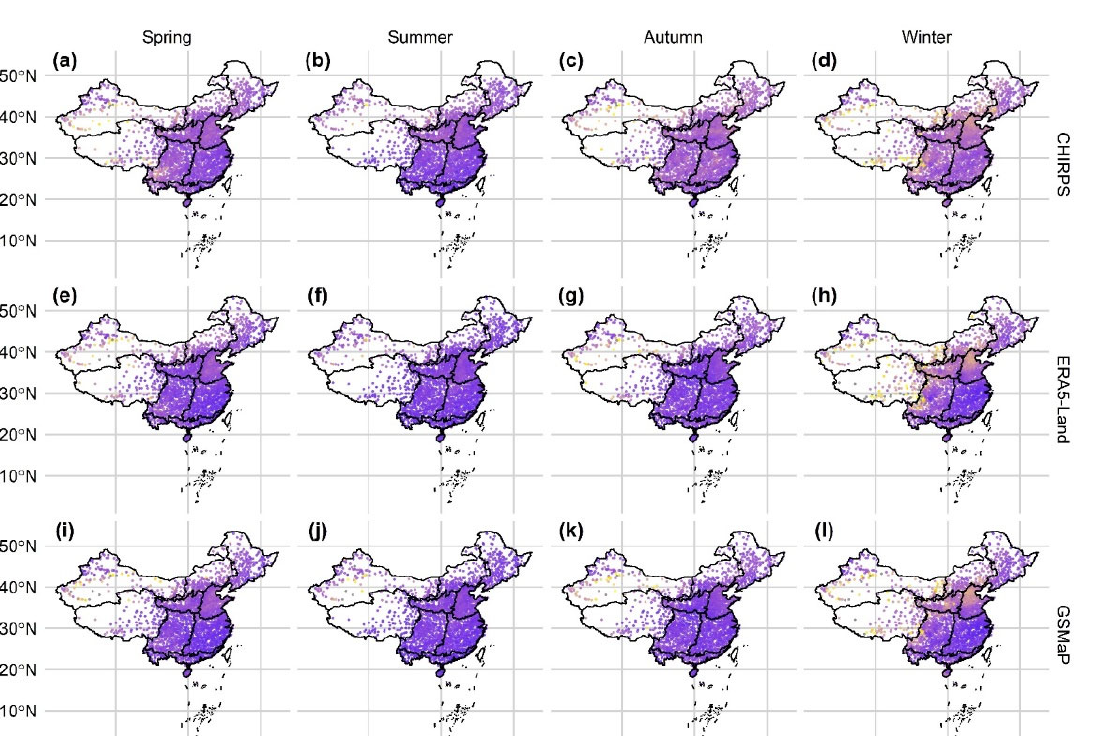
Figure 10. Distribution of RRMSE values of six products for different seasons between 2015 and 2019. From top to bottom: (a–d) CHIRPS, (e–h) ERA5 ‐ Land, (i–l) GSMaP, (m–p) IMERG, (q–t) MSWEP and (u–x) PERSIANN ‐ CCS ‐ CDR.